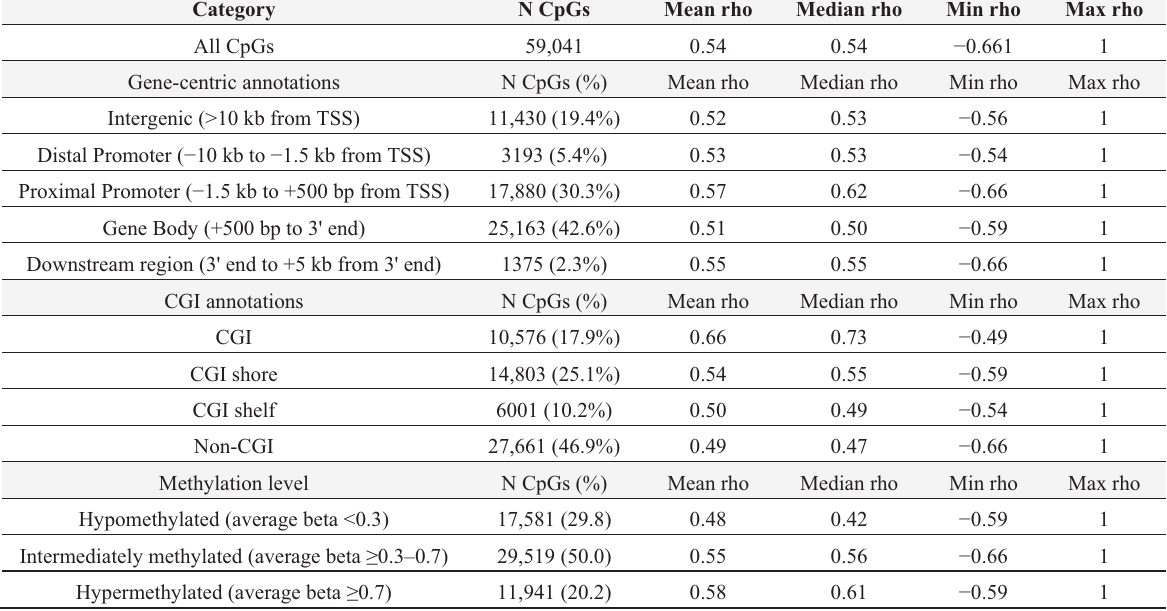
Table 1. Spearman correlation between the methylation values of monozygotic (MZ) twins for individual CpGs. Results are based on the most variable CpGs (N = 59,041). Category N CpGs Mean rho Median rho Min rho N CpGs (%) Mean rho Median